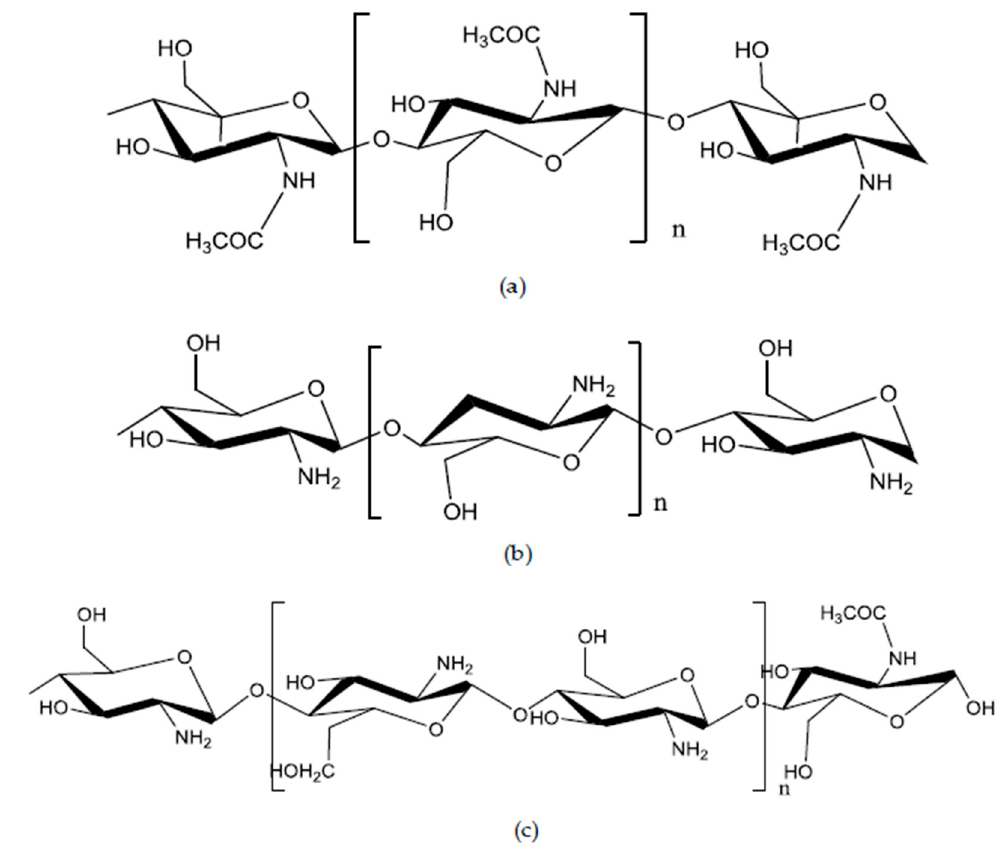
Figure 1. Structure of chitin ( a ); chitosan ( b ) and chitooligosaccharide ( n ≤ 9, c ).